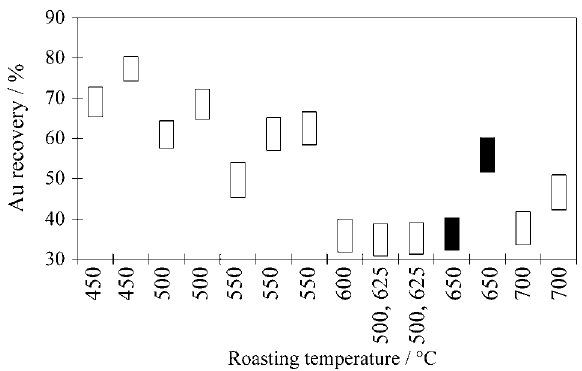
Figure 11. Mean silver recovery 95% confidence intervals from cyani- dation tests with different roasted products